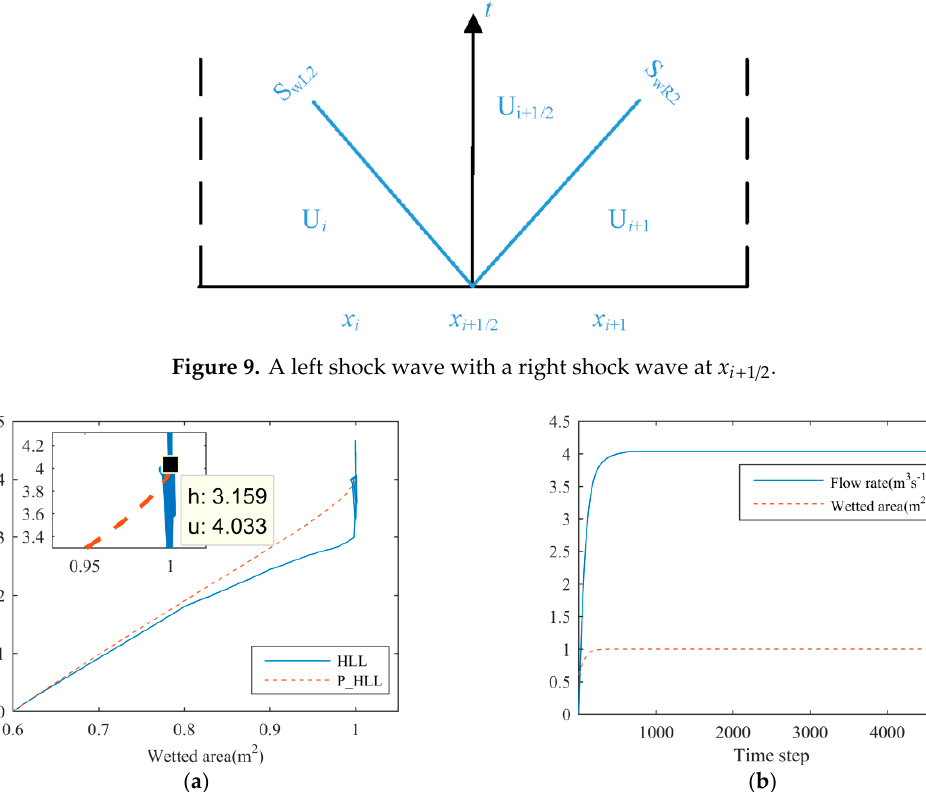
Figure 9. A left shock wave with a right shock wave at x i +1/2 .